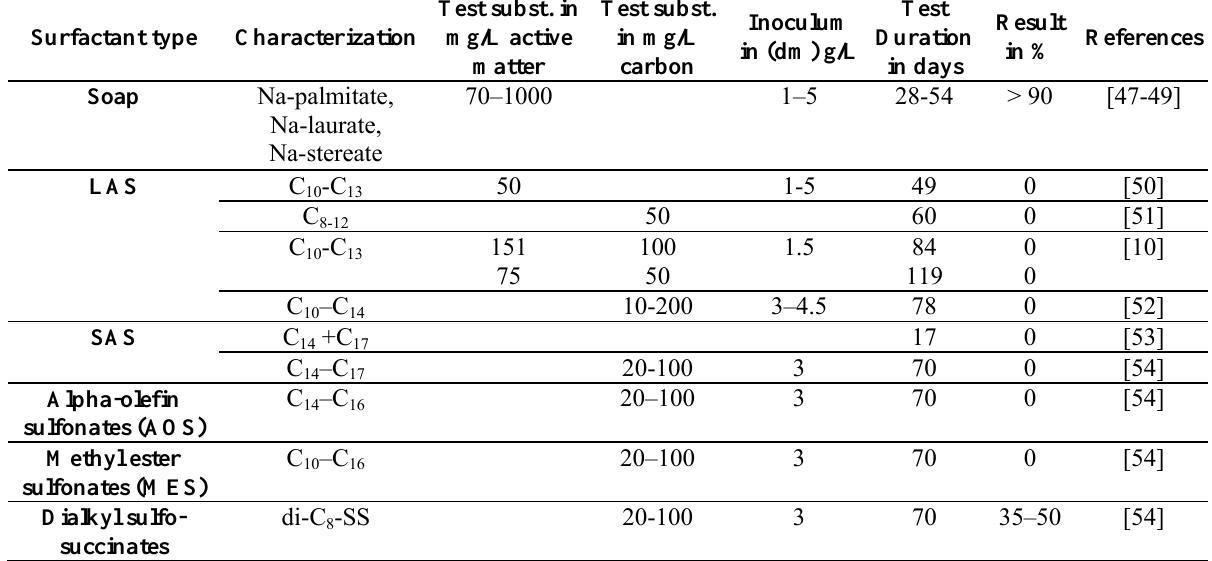
Table 5. Anaerobic biodegradability of anionics in screening tests (according ECETOC). Surfactant